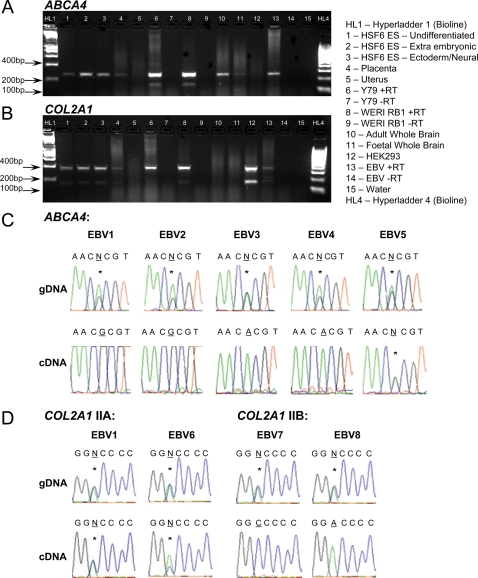
Experimental evidence for monoallelic expression at ABCA4 and COL2A1.(A) and (B) show transcripts of ABCA4 and COL2A1expressed in human embryonic stem cell lines (HSF6 shown here; H9, data not shown) before (lane 1) and after commitment to extra-embryonic (lane 2) or ectoderm/neural (lane 3) lineages, in human placenta (lane 4) but not uterus (lane 5). ABCA4 with exon 10 is expressed in Y79 (lane 6) and WERI RB1 (lane 8) eye cell lines, adult (lane 10) and fetal (lane 11) brain, and EBV lines (e.g. lane 13) used for sequencing (C), but not in HEK293 (lane 12). The isoform without exon 10 is seen in eye lines (lanes 6, 8). COL2A1 isoform IIA is expressed in Y79 (lane 6) and WERI RB1 (lane 8) cells. Neither isoform is expressed in adult (lane 10) or fetal (lane 11) brain. Both are expressed in HEK293 (lane 12), and in EBV lines (e.g. lane 13) used for sequencing (D). Water and –RT lanes are indicated. (C) and (D) show sequence analysis of genomic DNA (gDNA) and cDNA in EBV lines heterozygous for exonic SNPs. (C) EBV lines heterozygous for ABCA4 rs3112831 in gDNA; lines EBV1 to EBV4 homozygous (i.e. monoallelic) in cDNA specific for the exon 10-containing isoform. Line EBV5 is heterozygous, indicating that mono-allelic silencing is polymorphic. (D) EBV lines show monoallelic expression for COL2A1 SNP rs3737548 in PCR products specific for isoform IIB, but not IIA. Positions of SNPs (*) indicated by N where heterozygous, with the bp underlined for mono-allelic expression in cDNA.